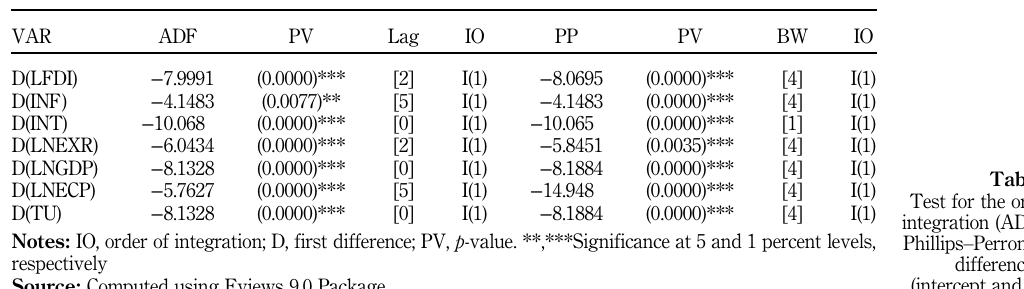
Table III. Test for the order